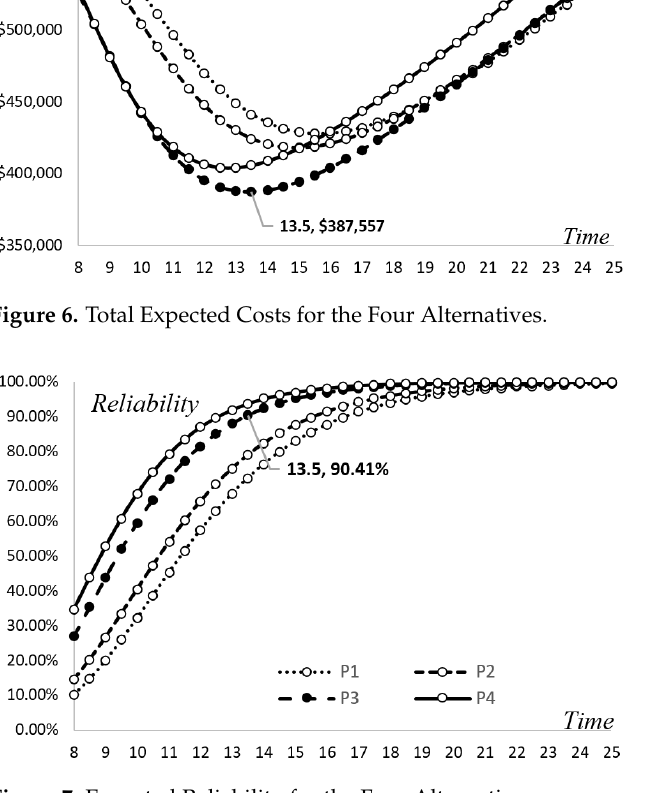
Figure 7. Expected Reliability for the Four Alternatives. Table 8. Related Parameters for the Original and New